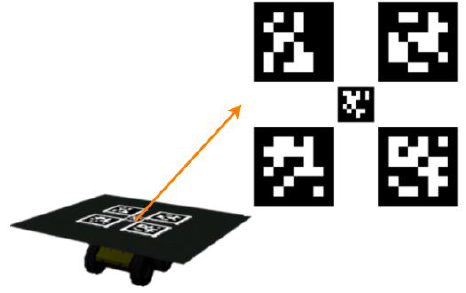
Figure 3. Landing pad of the visual detection system.